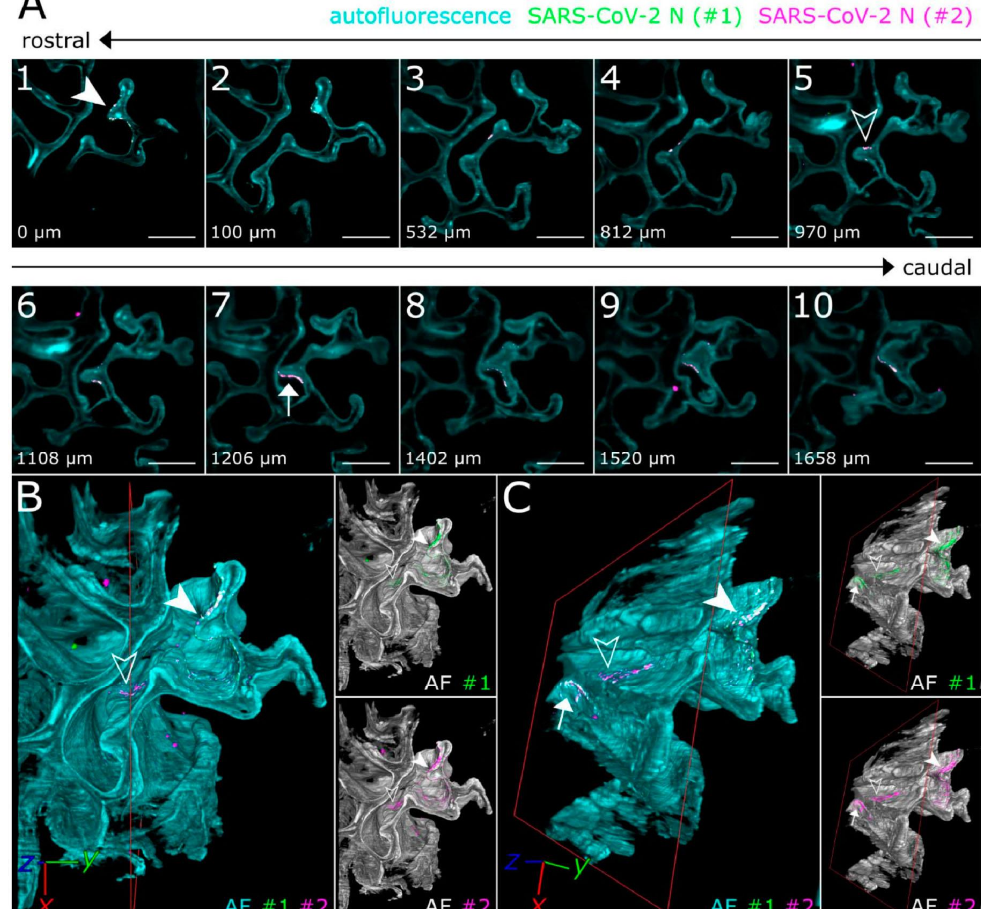
Figure 2. Light-sheet 3D fluorescence imaging of SARS-CoV-2-infected ferret nasal turbinates. Cyan—autofluorescence (overall tissue structure); green and magenta—staining with two different antibodies against N-protein. Only overlapping green and magenta signals are considered to be specific for SARS-CoV-2-infected cells (marked by arrows). ( A ) Individual optical sections. ( B , C ) 3D reconstructions. Images from Zaeck et al. [26].